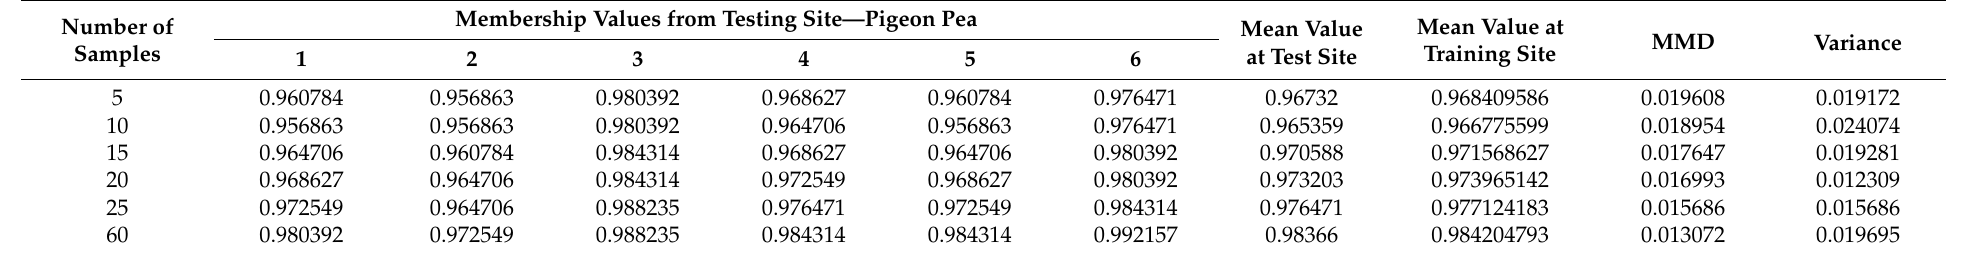
Table 9. Effect of increase in sample size by comparing membership values between Pigeon Pea Training fields and Pigeon Pea Test fields for proximity—Mean training parameter based PCM classifier.